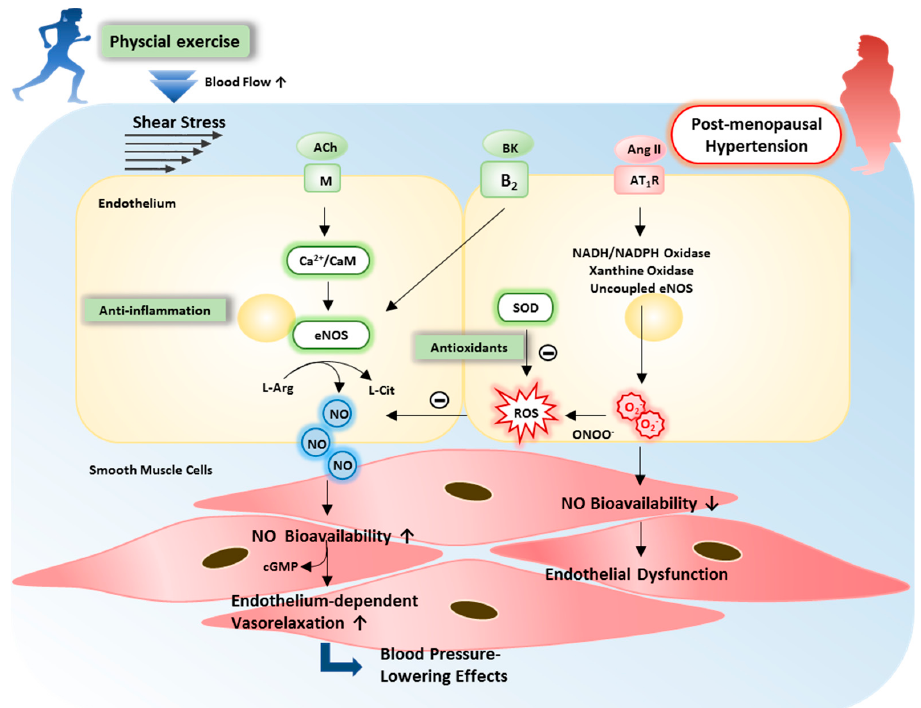
Figure 1. The potential mechanisms of exercise training on vascular endothelial dysfunction in postmenopausal hypertension. The mechanisms initiating endothelial dysfunction involve the oxidative stress, inflammation, and impaired reflect nitric oxide (NO) bioavailability and vasorelaxation in postmenopausal hypertension. Among many ROS, increases in nicotinamide adenine dinucleotide phosphate (NAD(P)H) oxidase, xanthine oxidase, and uncoupled endothelial NOS (eNOS) are associated with hypertension. Exercise training evokes the improvements in anti-inflammation, antioxidant production, NO bioavailability, and endothelium-dependent vasorelaxation. This partly explains the blood-pressure-lowering effects of exercise in postmenopausal hypertension. Specifically, the exercise-induced shear stress and activation of various receptors (e.g., M, B 2 ) lead to the increases in NO production and bioavailability by inducing eNOS expression in the endothelium. ↑ : up-regulation; ↓ :